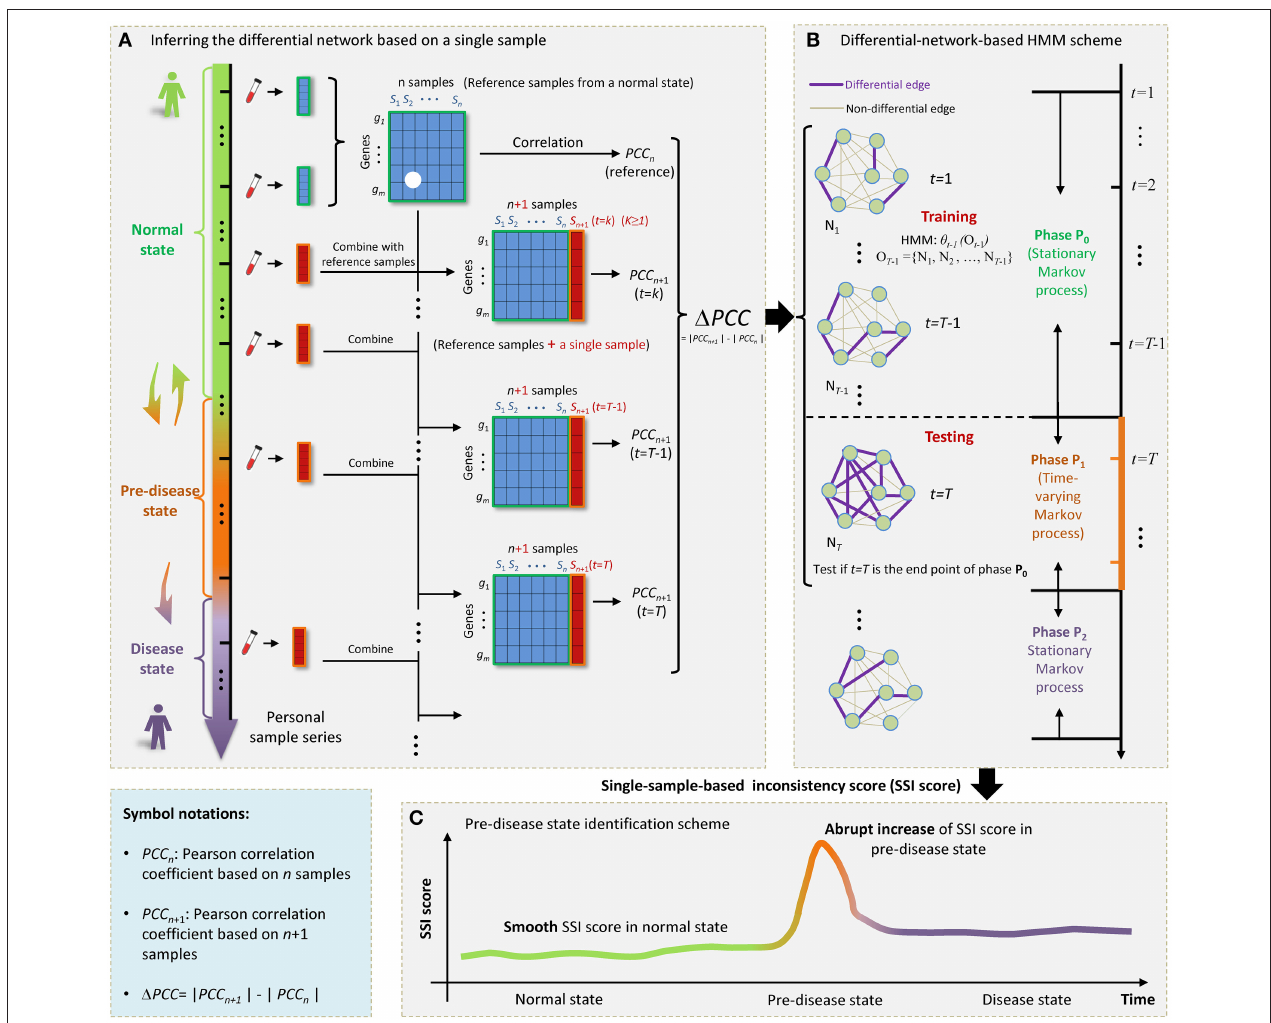
FIGURE 1 | The outline for identifying the SSI score based on HMM. (A) The progression of complex diseases is generally modeled as three states, i.e., a normal state, a pre-disease state, and a disease state. The pre-disease state is immediately before the sudden deterioration, which is sensitive to treatment and reversible to the normal state. The disease state is usually irreversible even with intensive medical care. For an individual, samples from a few initial time points can be regarded as reference. Each single case sample was added to the reference, forming a series of combining samples. (B) At each time point t = 1, 2, … T , a differential network N t was constructed by PCC. (C) The sharp increase of SSI score signals the upcoming critical transition into the disease